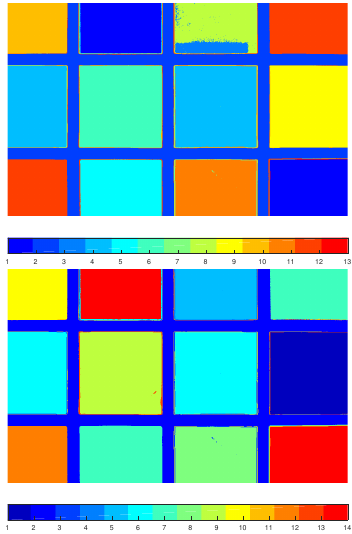
Figure 8. K-spatialmedian clustering results when K is 13 and 14 for the original interpolated data.